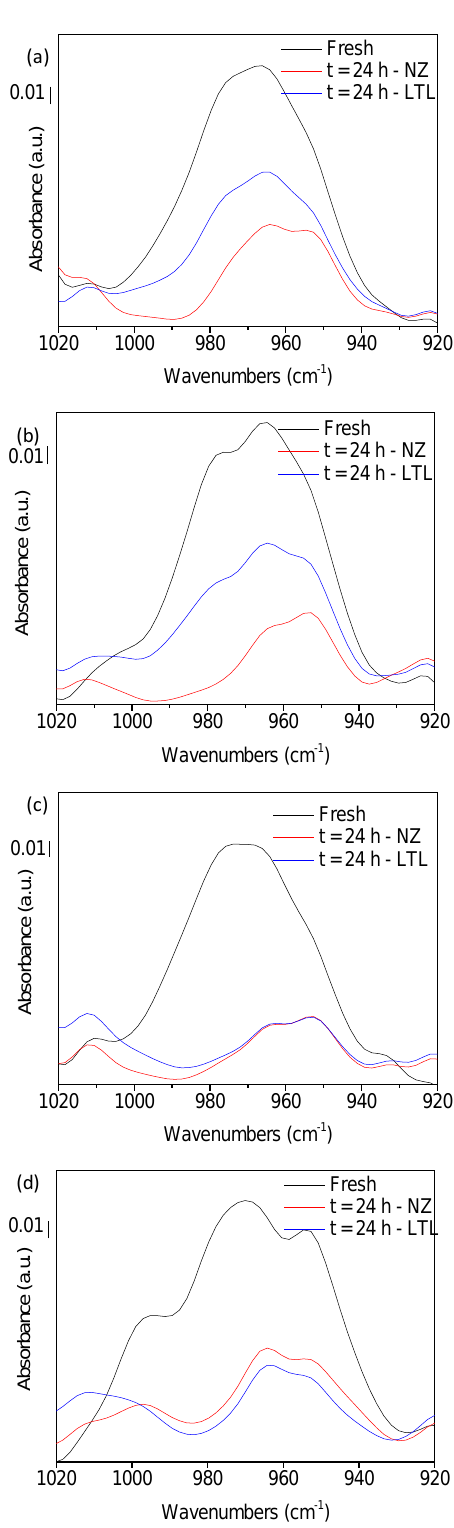
Figure 4. P–O–C FTIR band vibrations of ( a ) SA-C2, ( b ) SA-C3, ( c ) SB-C2, and ( d ) SB-C3 in their fresh form (black) or following 24 h of oxidation at 150 °C in absence (red) or presence (blue) of LTL nanozeolite.